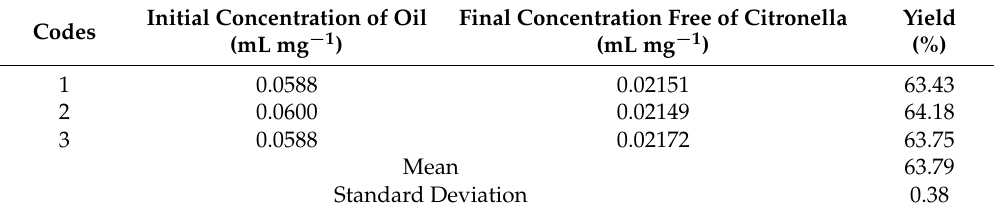
Table 2. Yield of the complexation process of citronella essential oil by β